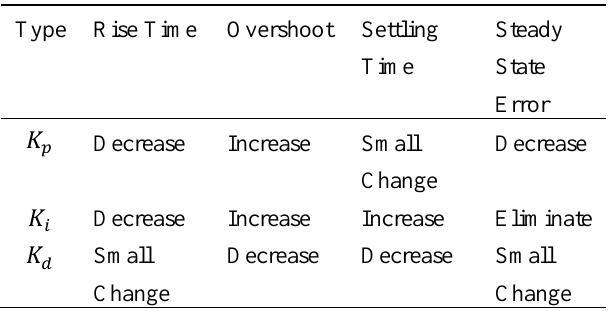
The effects of gain coefficients on the performance of